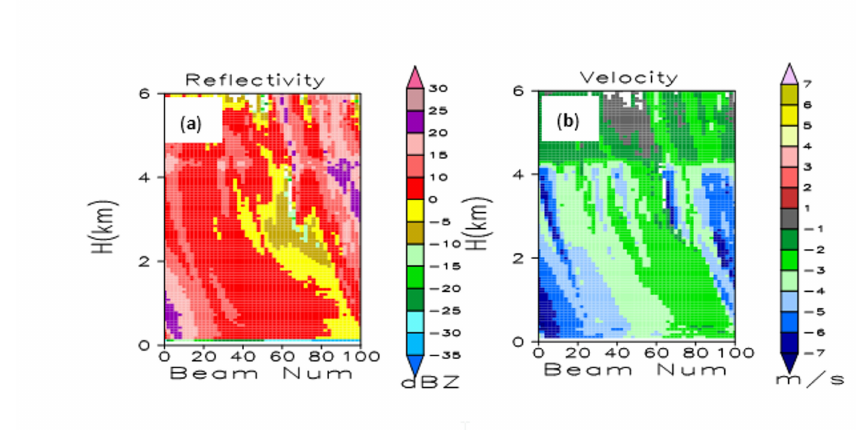
Figure 10. Time–height cross sections of reflectivity ( a ) and velocity ( b ) between 13:18 and 13:45 in the black